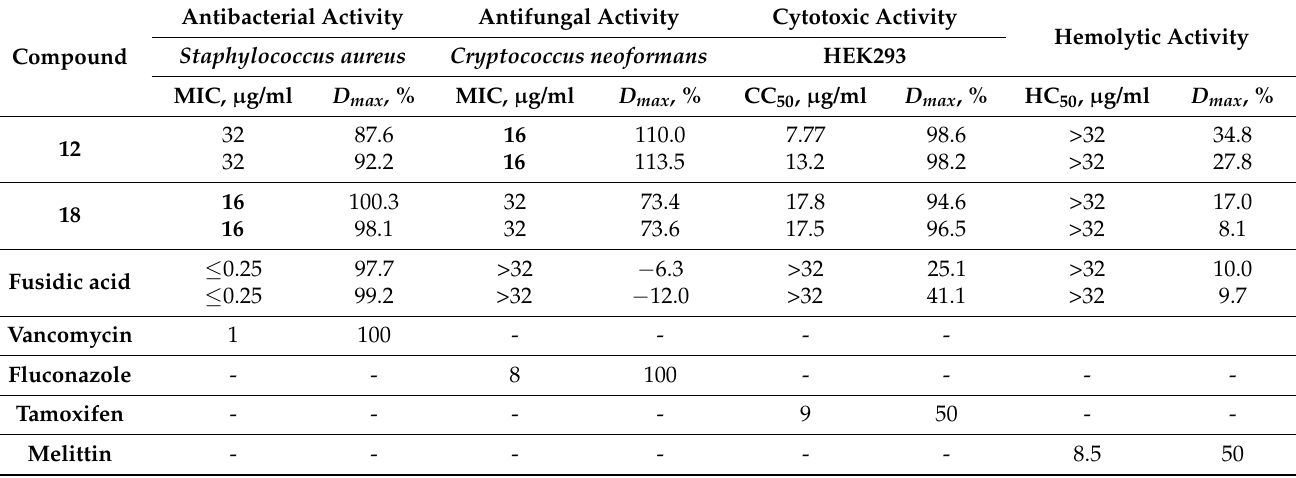
The introduction of polyamine moieties into the fusidane triterpenoid molecule (compounds 19–22 ) led to an expansion of the spectrum of antimicrobial activity, namely, the appearance of a positive effect on Gram-negative pathogens (Table 3), which may be due not only to the interaction of the compounds with the bacterial elongation factor EF-G, similarly to FA [34], but also to changes in the membrane activity. As follows from Table 3, compounds 19–22 exhibited the greatest antimicrobial effect against the bacterial strain S. aureus (MIC 2.0–8.0 µ g/mL) and the fungal culture C. neoformans (MIC 1.0–2.0 µ g/mL). The methyl fusidate derivative with a spermine moiety ( 22 ) had the widest range of antimi- crobial activity. This compound influences the viability of S. aureus (MIC 2.0 µ g/mL), E. C. albicans (MIC 32.0 µ g/mL), and C. neoformans (MIC 1.0 µ g/mL). The FA derivative with spermidine substituent 19 inhibited the growth of S. aureus (MIC 32 µ g/mL) and C. neoformans (MIC 8.0 µ g/mL) and proved to be the least toxic and hemolytically active compared to other polyamine analogues. The transformation of this molecule to methyl ester to give compound 20 elevates the antimicrobial and antifungal activity; however, this is also accompanied by an increase in the toxicity and hemolytic effect (Table